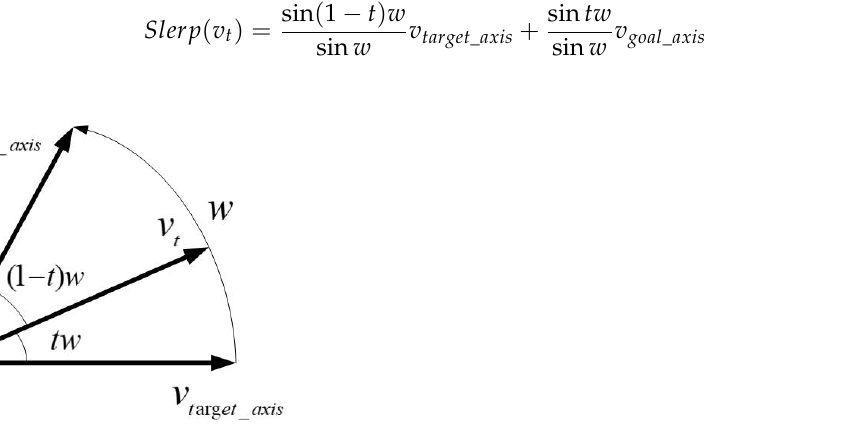
Figure 8. Schematic diagram of two-vector linear interpolation in a two-dimensional plane [32].